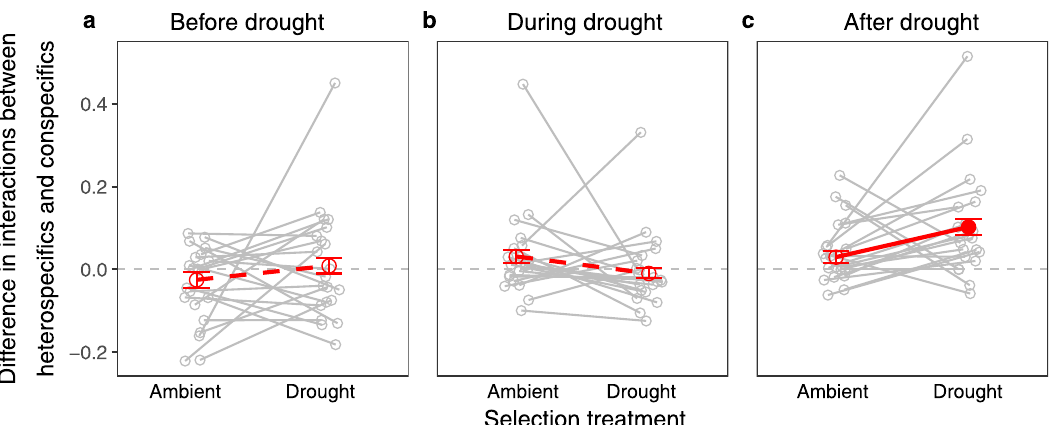
Fig. 4 Effects of selection treatment (ambient- vs. drought-selected plants) on the difference between heterospeci fi c and conspeci fi c interactions. The differences in plant interactions were calculated before ( a ), during ( b ), and after ( c ) the drought event in the glasshouse. The solid red line indicates a signi fi cant difference between the two selection treatments (see Supplementary Table 8). Red points and error bars show means ± standard error. The fi lled red point shows a signi fi cant difference from zero (horizontal dashed lines; see Supplementary Table 7), i.e., weaker heterospeci fi c than conspeci fi c competition. Gray points represent means for species pairs (standard errors for species pairs not shown). Gray lines connect the same species pair between the two selection treatments. Source data are provided as a Source data fi le. The numbers of mixtures per species pair (gray points) and per selection treatment (red points) are provided in the Source data fi